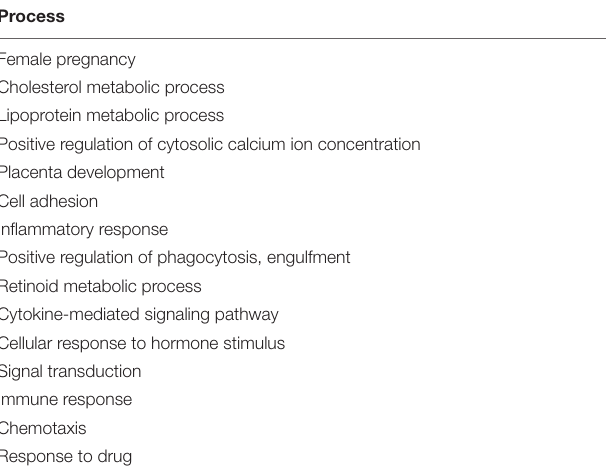
TABLE 4 | Biological processes enriched in mRNAs that were associated with lncRNA and miRNA during trophoblast differentiation a , and ranked by adjusted p